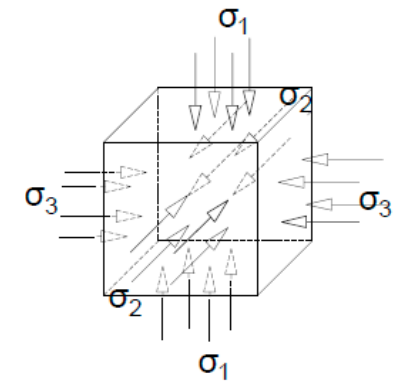
Figure 2. Schematic diagram for loading on specimen.